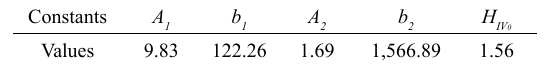
Table 2. Exponential power curve parameters for experimental hardness behavior as a function of penetration depth. Constants